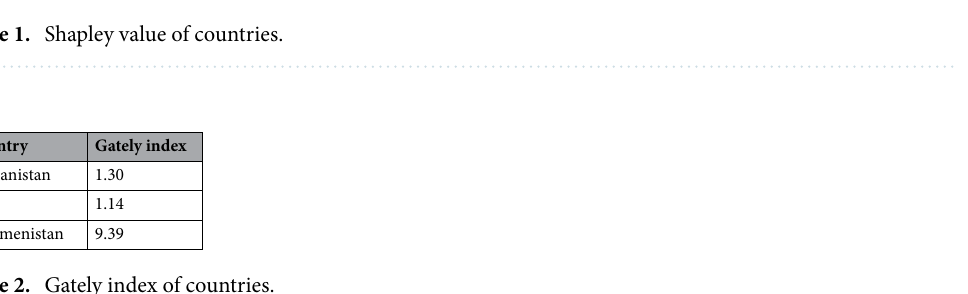
Table 2. Gately index of